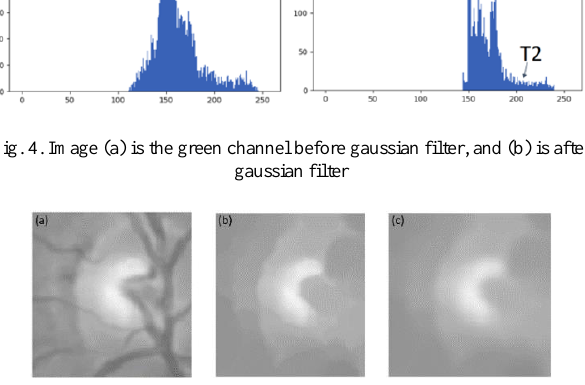
Fig. 5. The optic disc as the RoI (a) and after the bottom hat (b) to remove the blood vessel then proceed to filtering using Gaussian filter (c) to make the optic cup more prominent.